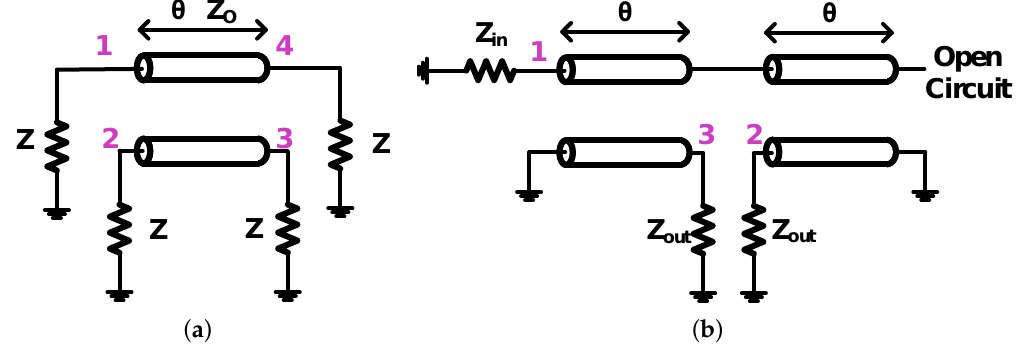
Figure 1. Symmetric coupled line with ports’ definition ( a ) and the conventional Marchand balun ( b ).